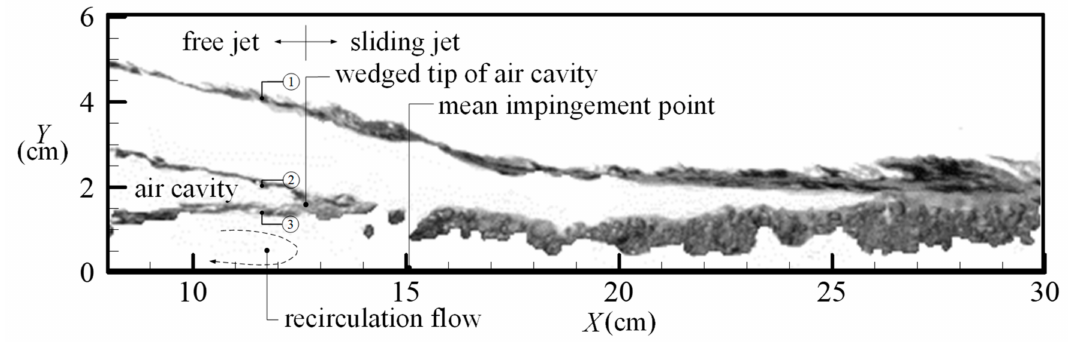
Figure 10. A magnified view for superposing three instantaneous SIM images taken partially from those captured in the FOVS 1 with removal of the blurred